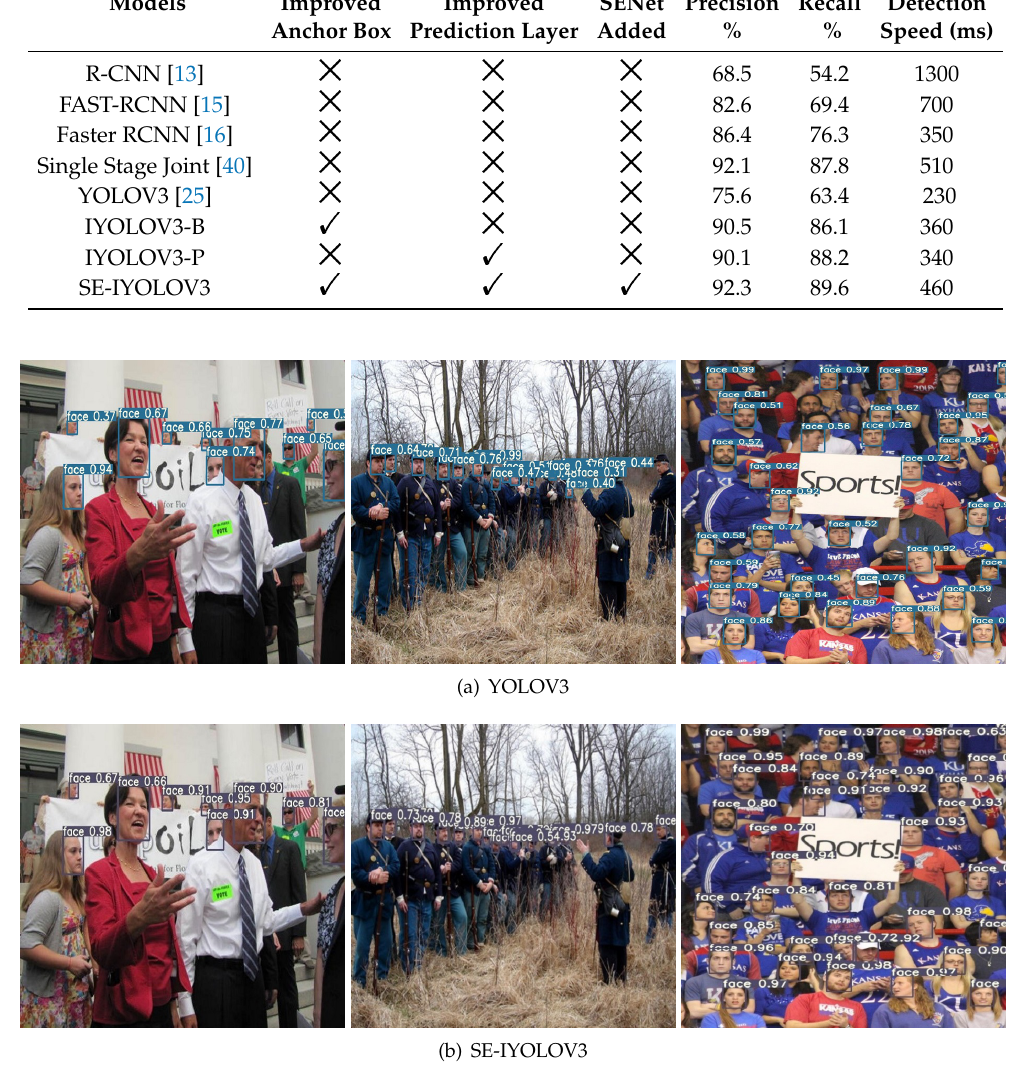
Figure 6. Face detection results via YOLOV3 and the proposed SE-IYOLOV